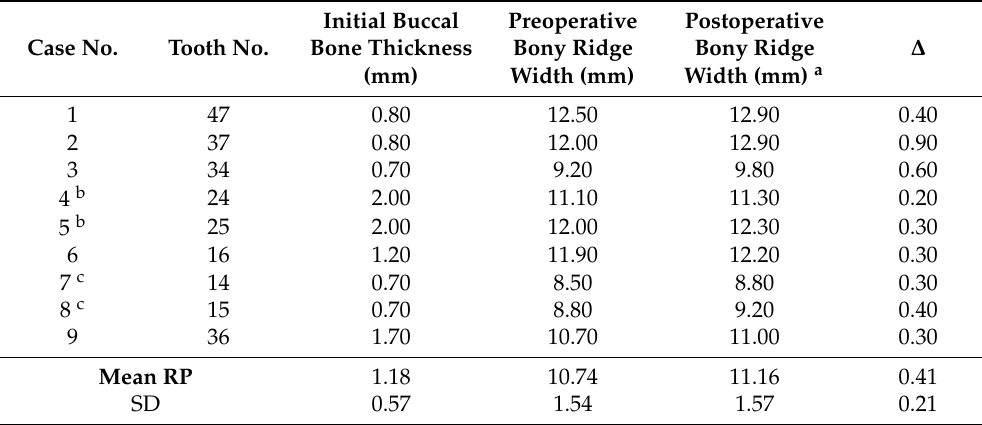
Table 1. Difference between preoperative and postoperative ridge width. RP = ridge preservation; SD = standard deviation. a Postoperative measurements were taken at 4 months after ridge preserva- tion. b Same patient, double extraction. c Same patient, double extraction. ∆ = differences between the preoperative and postoperative ridge width values of the same site.